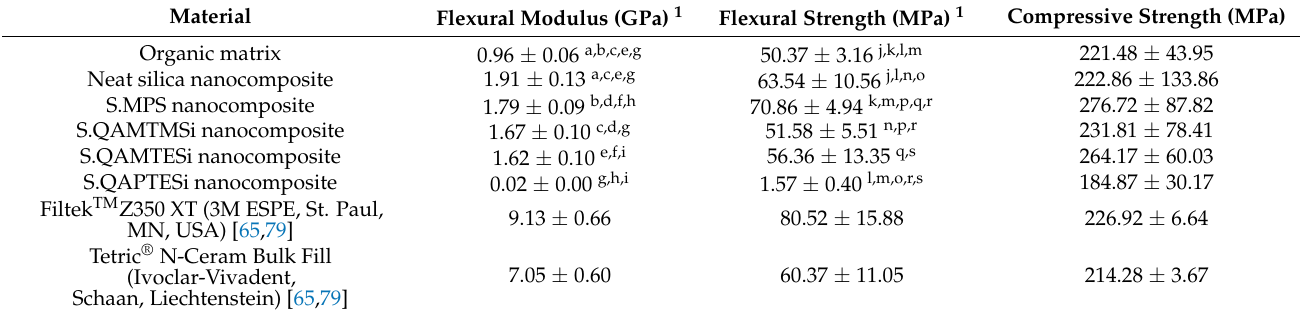
Table 4. Mean values ± standard deviation (SD) of flexural modulus and median values ± inter-quartile range (IQR) of flexural strength and compressive strength for Bis-GMA/TEGDMA matrix and dental nanocomposite resins. Literature data for typical commercially available dental resins are also